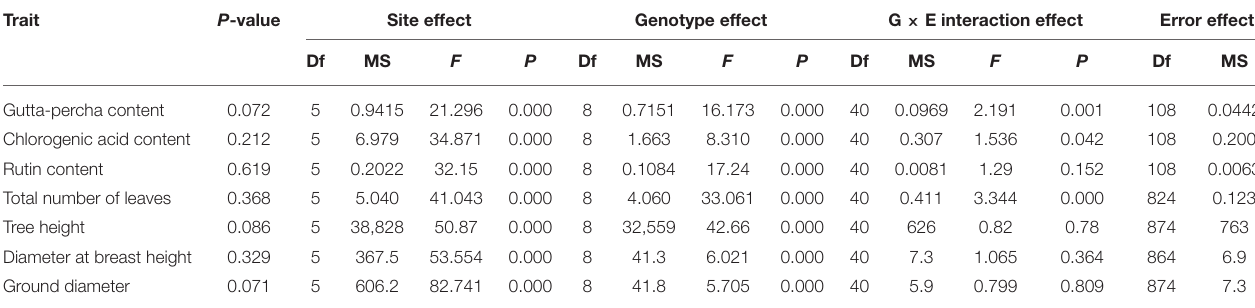
TABLE 3 | Variance analysis of traits.